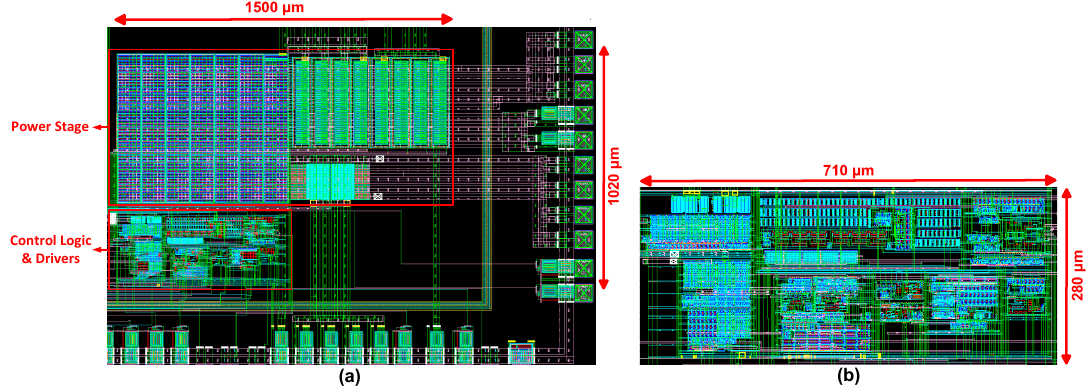
Figure 13. Layout of the proposed harvesting interface with (a) integrated power stage version and (b) discrete devices power stage version.